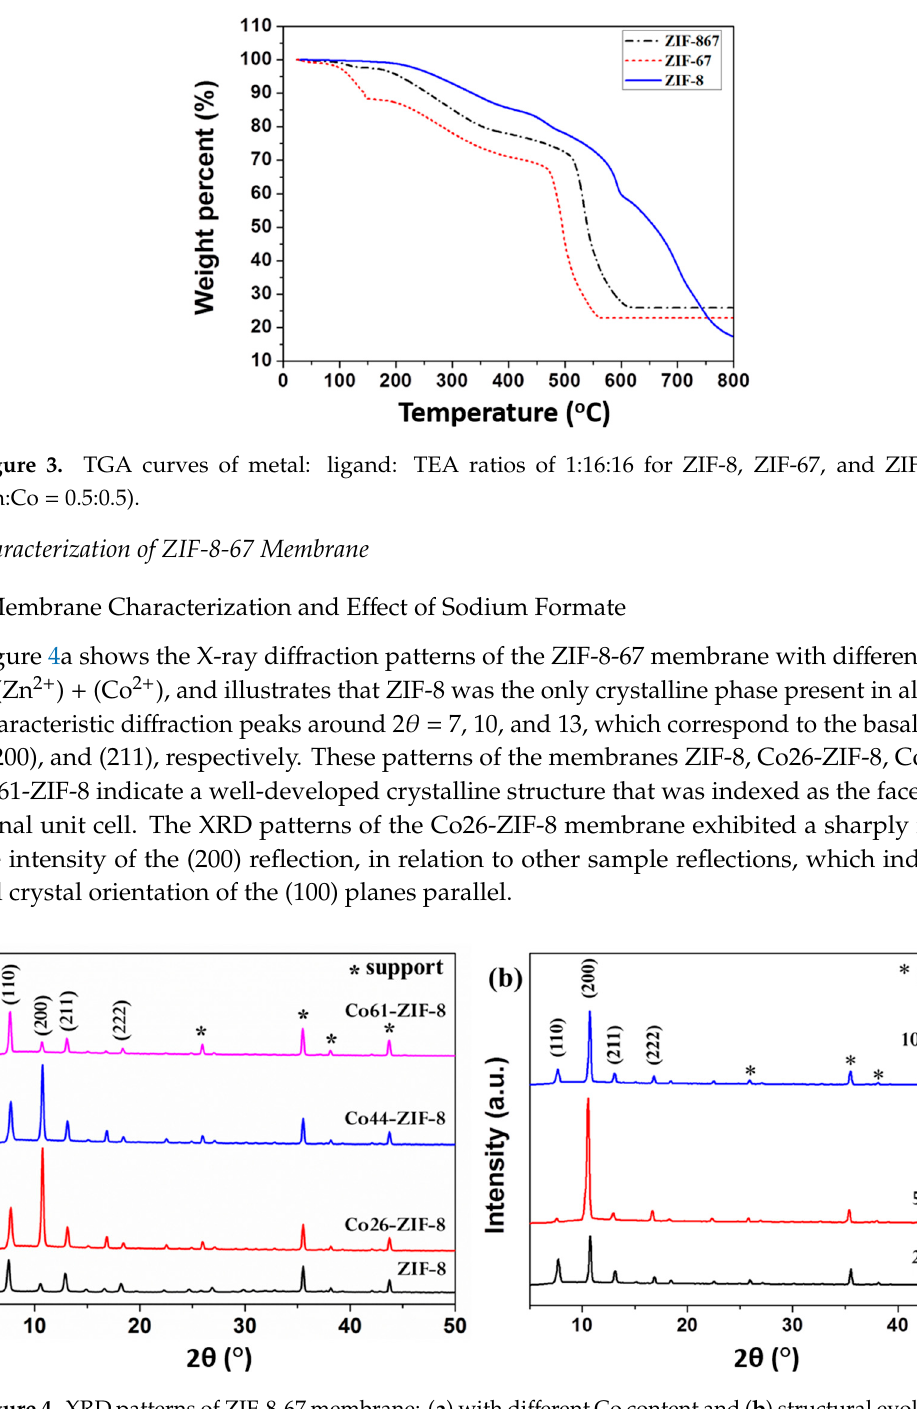
Figure 4. XRD patterns of ZIF-8-67 membrane: ( a ) with different Co content and ( b ) structural evolution of the Co44-ZIF-8 membrane with different SF concentrations (2.7, 5.4, and 10.8 mmol at 100 °C for 2 h).